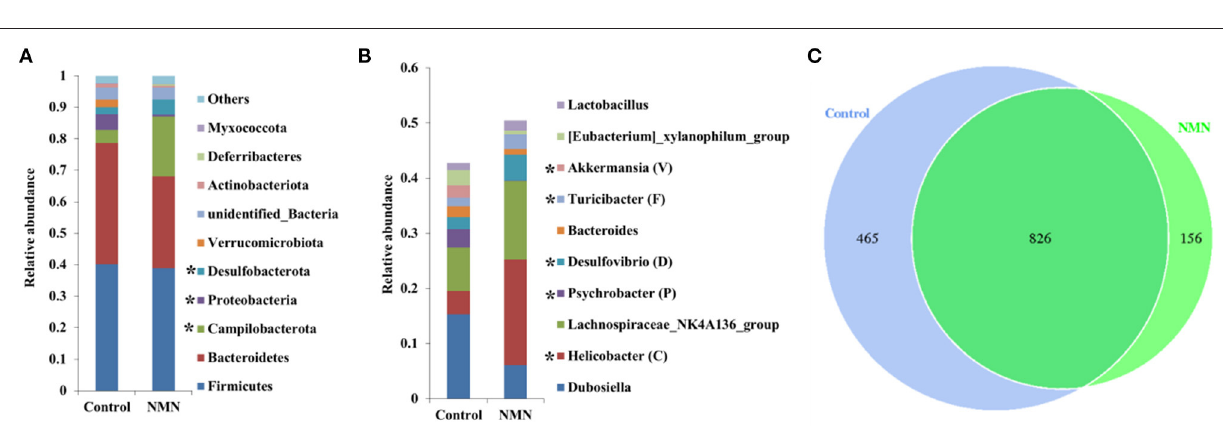
FIGURE 5 | Supplementary effect of NMN on dominant fecal bacteria in pre-aging mice. (A) Phylum level, (B) genus level, and (C) venn diagram. *Indicates significant difference at p < 0.05